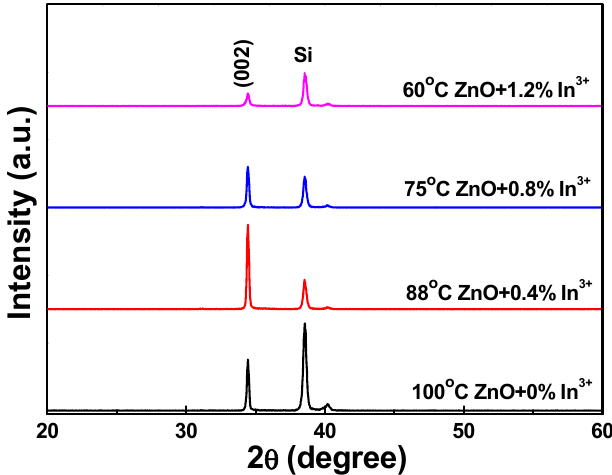
Figure 6. XRD patterns of the synthesized In 3+ -doped ZnO nanowires as a function of the concentration of In 3+ ions (or synthesis temperature).